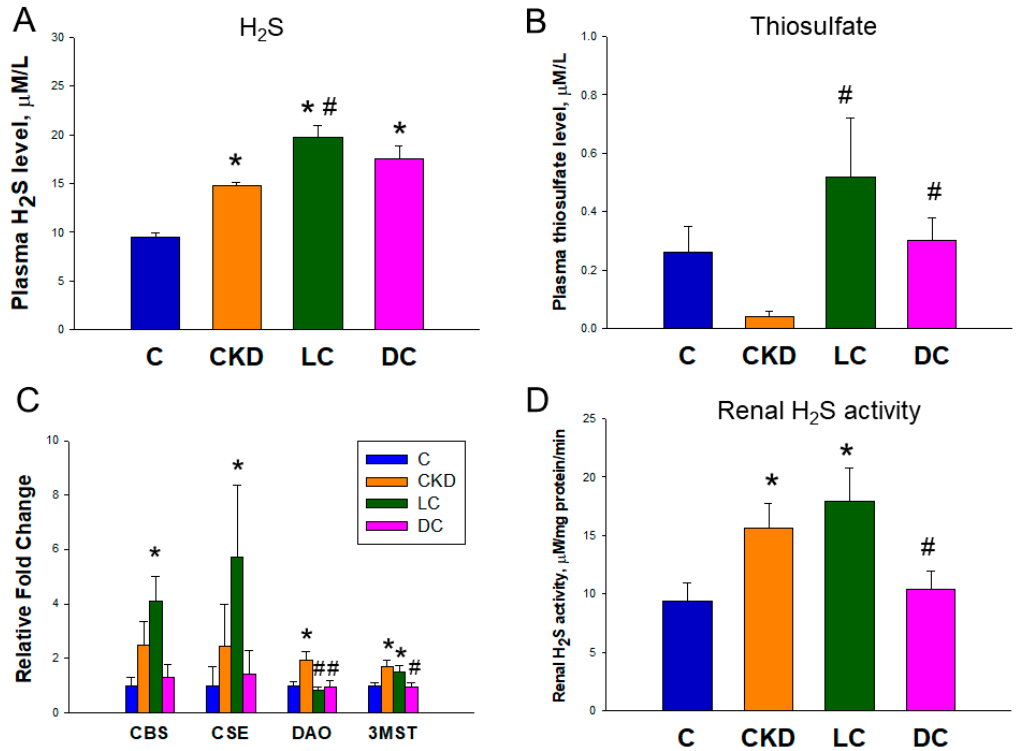
Figure 2. Effect of maternal chronic kidney disease (CKD), L -cysteine (LC), and D -cysteine (DC) on ( A ) plasma H 2 S level, ( B ) plasma thiosulfate level, ( C ) renal mRNA expression of H 2 S-generating enzymes, and ( D ) renal H 2 S-releasing activity. n = 8/group; * p < 0.05 vs. C; # p < 0.05 vs. CKD.